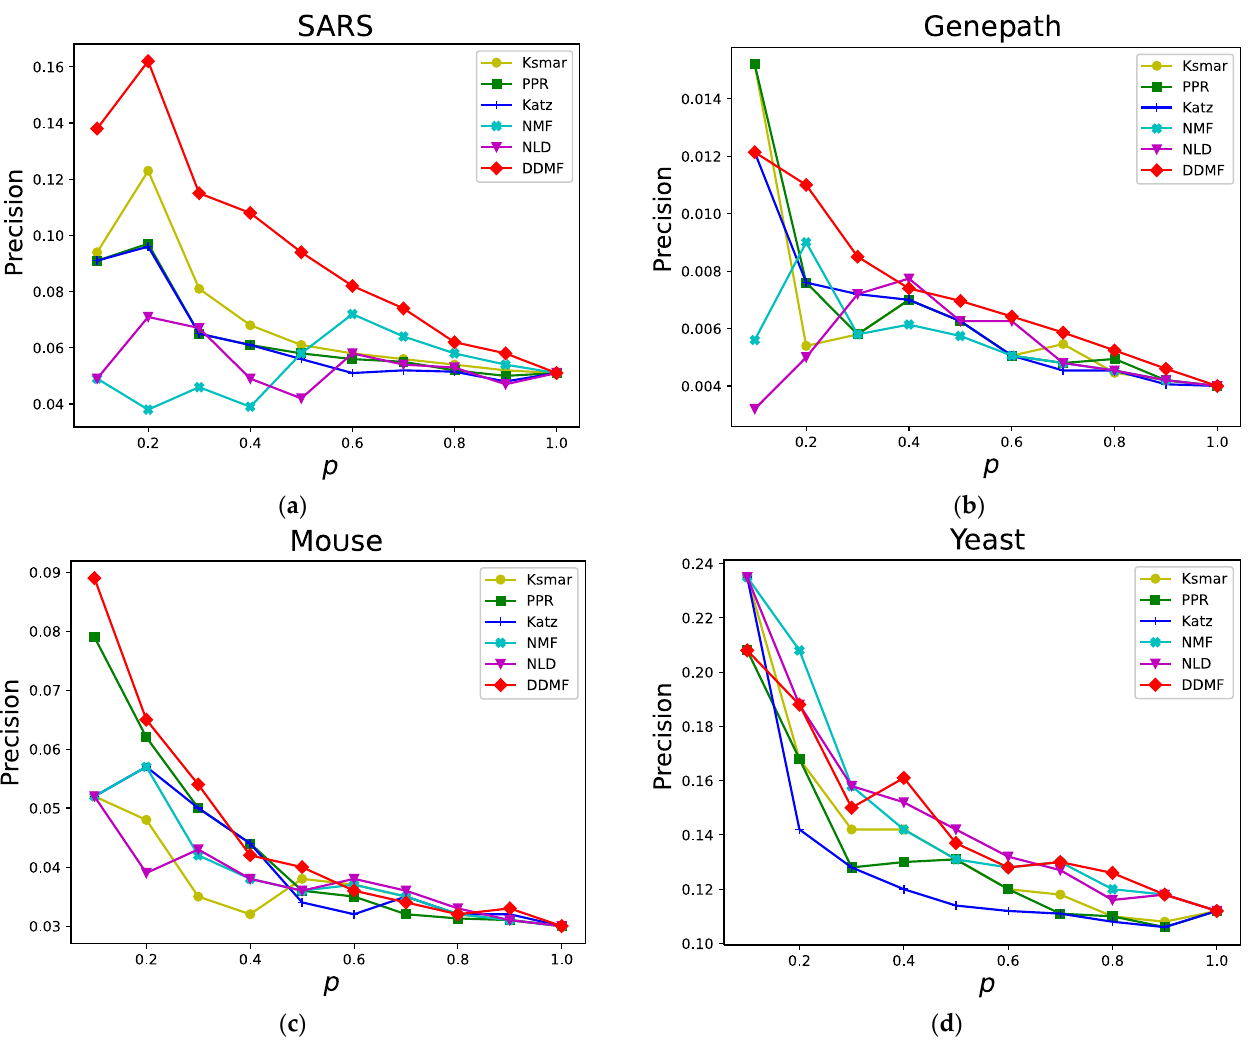
Figure 2. Precision rate results in four networks: ( a ) SARS network; ( b ) Genepath network; ( c ) Mouse network; ( d ) Yeast network.